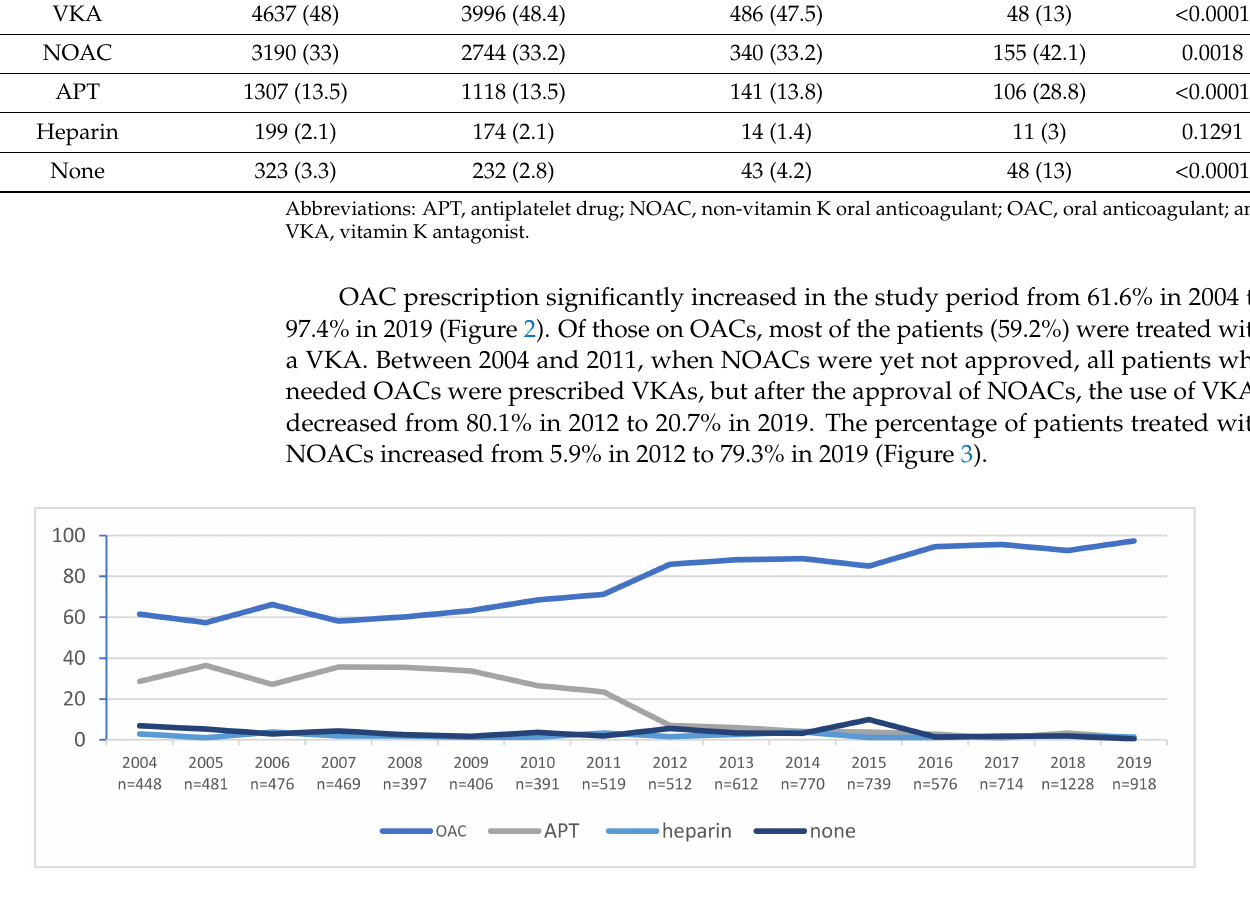
Figure 2. Temporal trends of antithrombotic therapy in all study patients. Abbreviations: APT, antiplatelet drug, and OAC, oral anticoagulant.